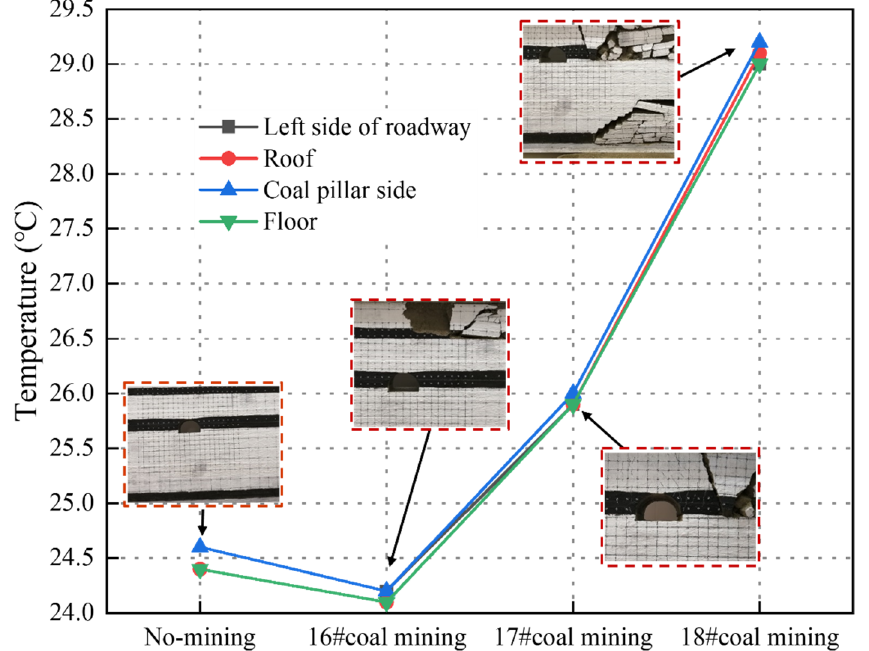
Figure 12. The temperature changes of the surrounding rock of the roadway at different locations during the mining of different coal seams.